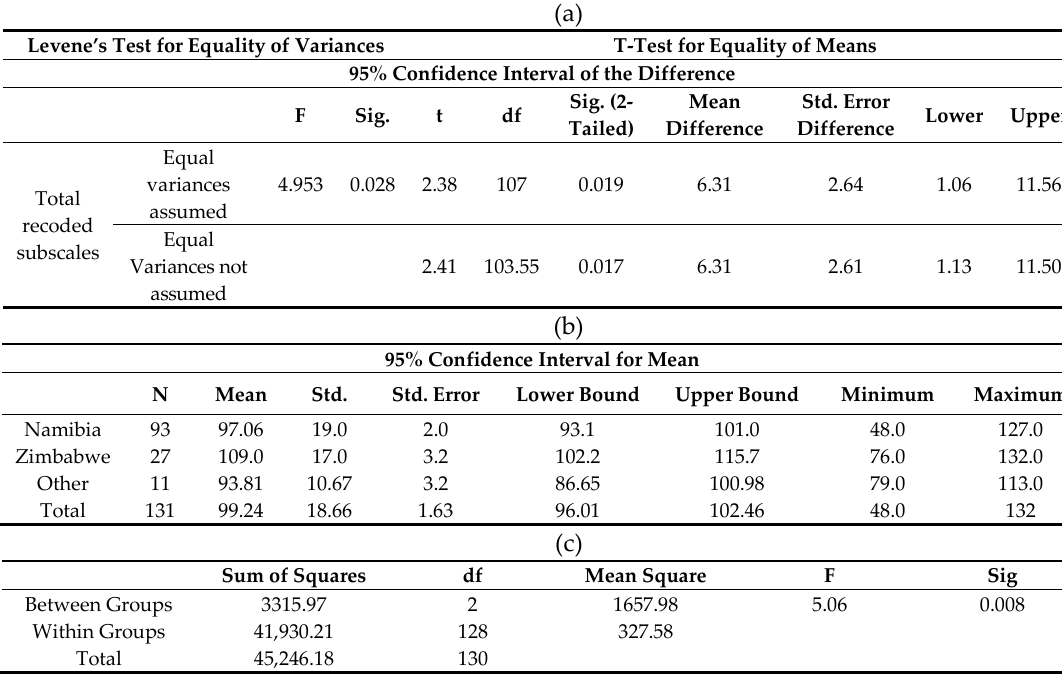
Table 4. Country of Origin by Total IRMA Score.